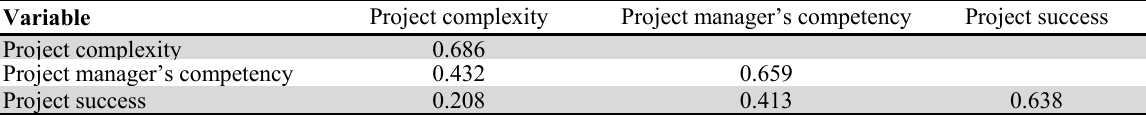
A divergent validity study for the variables